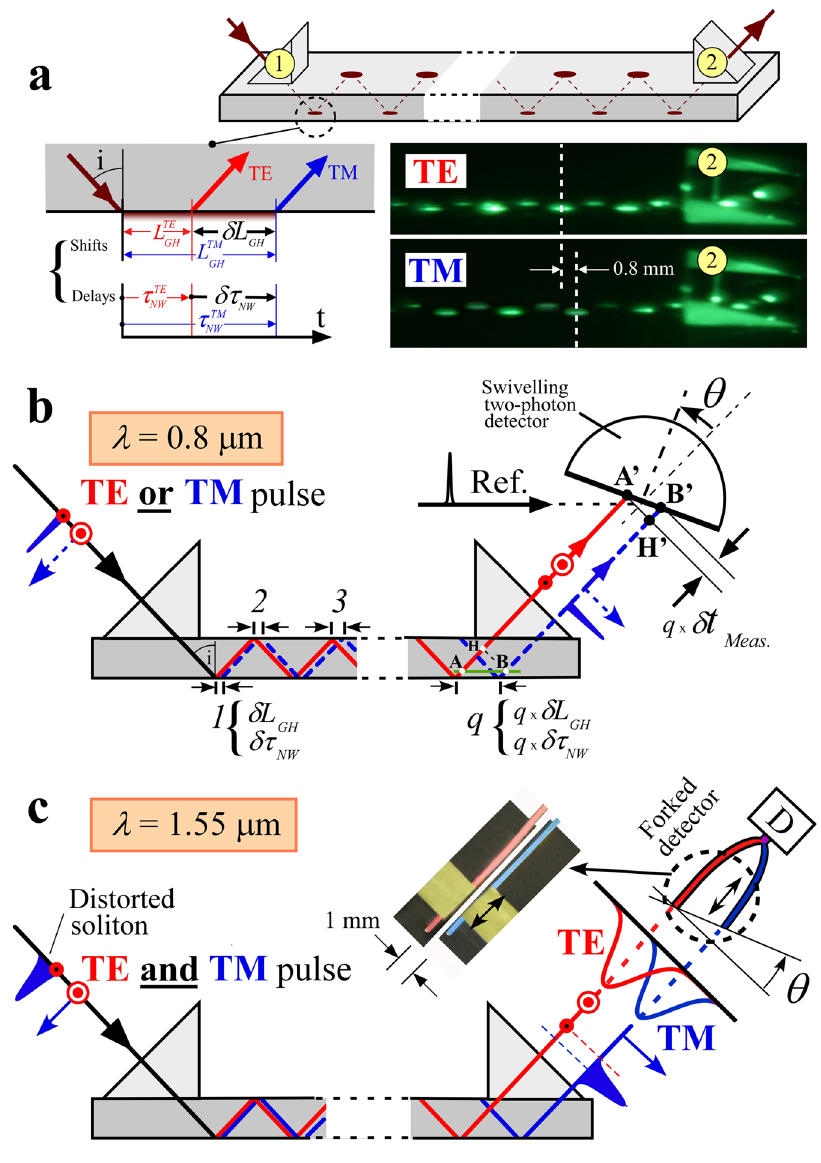
Figure 1. Goos-Hänchen shifts and Newton-Wigner time delays in different regimes. ( a ) A Ti:Sa laser beam at a wavelength of 808 nm is coupled into a waveguide via the prism 1 and undergoes up to 161 total internal reflections before being outcoupled by the prism 2. The laser could operate either in CW or pulsed regime. The total Goos-Hänchen shifts between TE and TM beams reaches 0.8 mm. It is directly observed through an infrared viewer giving the green colour. ( b ) In the femto-second regime, the Newton-Wigner delay q δτ Meas . is measured by a correlation with a fixed reference beam on a two-photon detector, whose surface of detection could be rotated by an angle θ . The pulse polarizations are successively TE or TM. Note that for θ = 0°, the TE and TM pulses arrive at the same time due to an automatic compensation in the second prism. (c) In the soliton regime, when a randomly polarized soliton at a wavelength of 1550 nm is launched into a telecommunication system including a waveguide, a forked fibre detector can take advantage of the intermingled spatial and temporal shifts to compensate for the